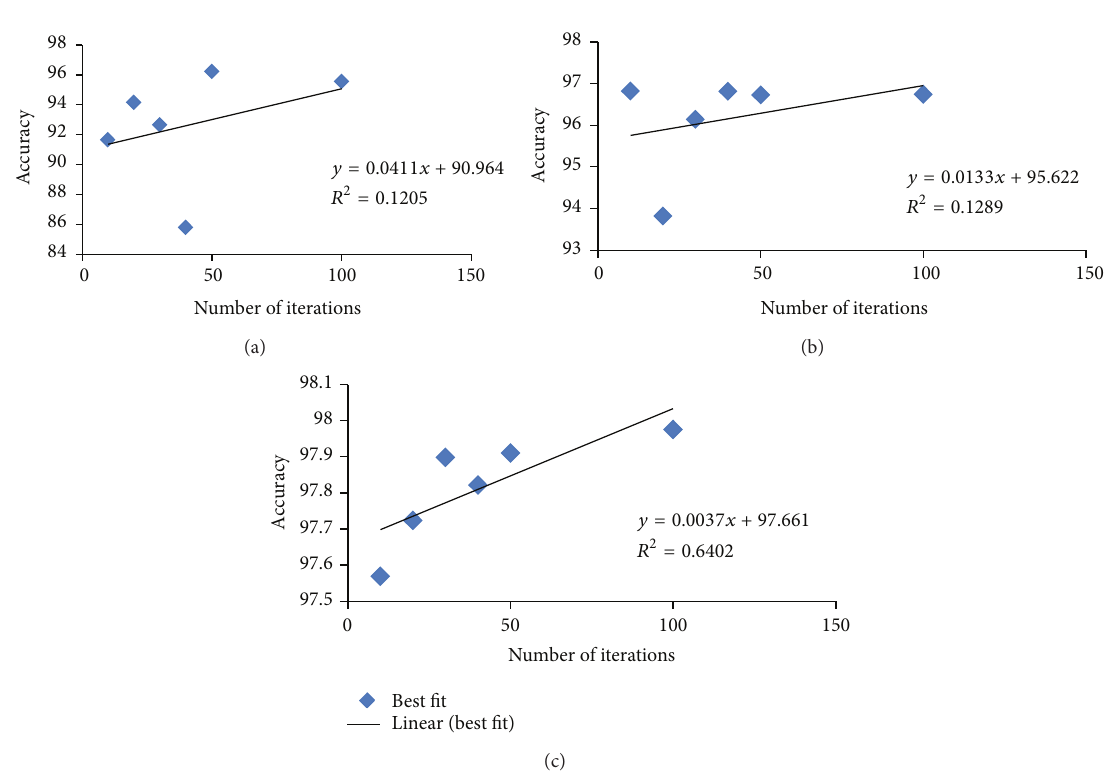
Figure 6: Performance measurement of data 1 for the three algorithms: (a) fuzzy 𝐶 -means clustering, (b) fuzzy 𝐾 -means clustering, and (c) fuzzy subtractive clustering.